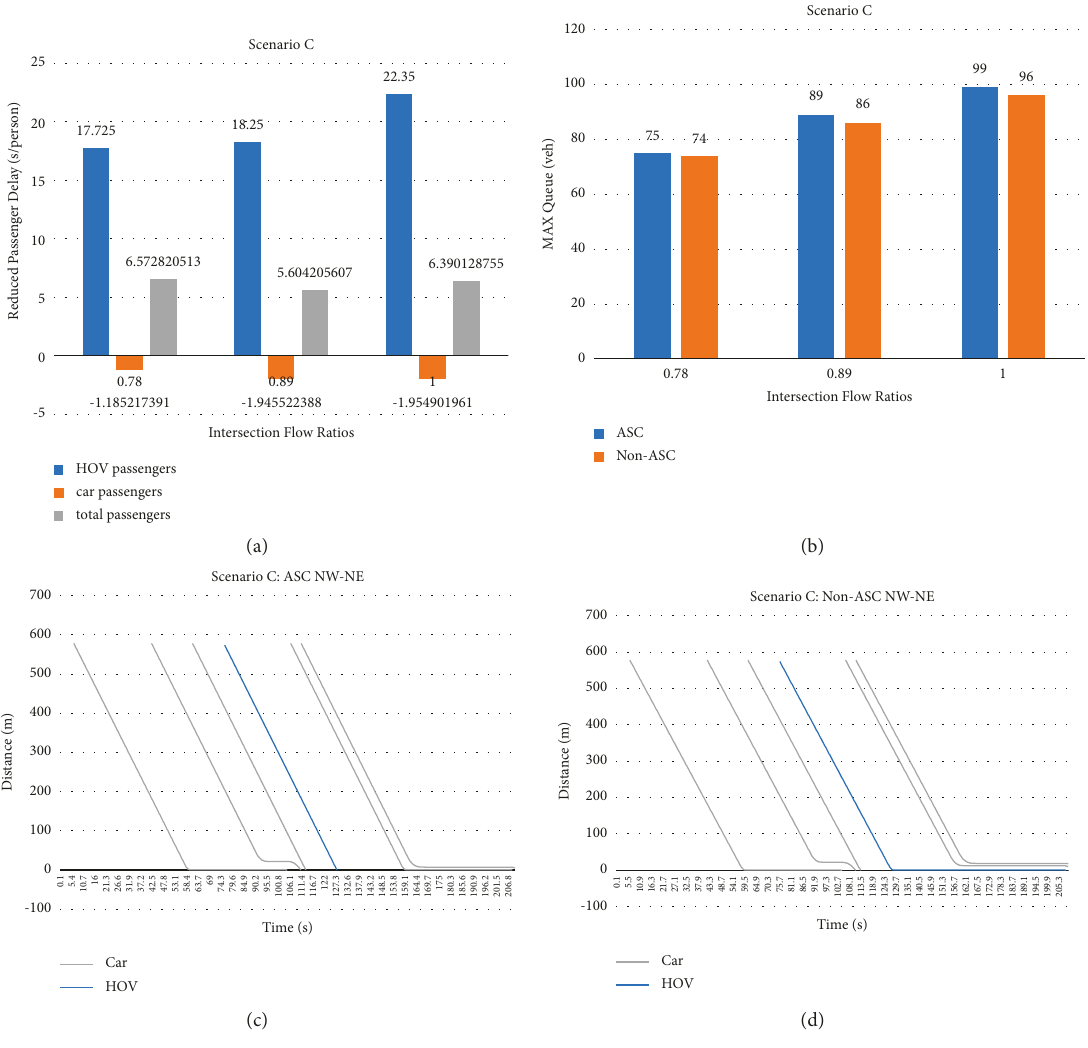
Figure 9: ASC Optimization results in scenario C (a) Reduced passenger delays (b) Max queue (c) Vehicle trajectories under ASC (d) Vehicle trajectories under fixed